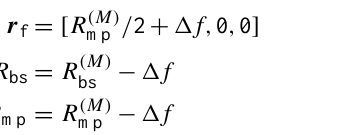
model (Eq. 2) coincide with the desired bow shock